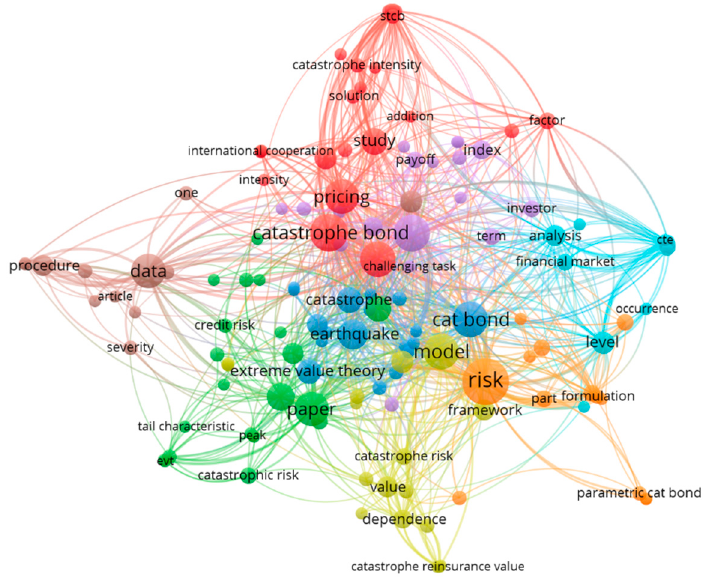
Figure 2. Mapping 23 models of earthquake disaster bond pricing.